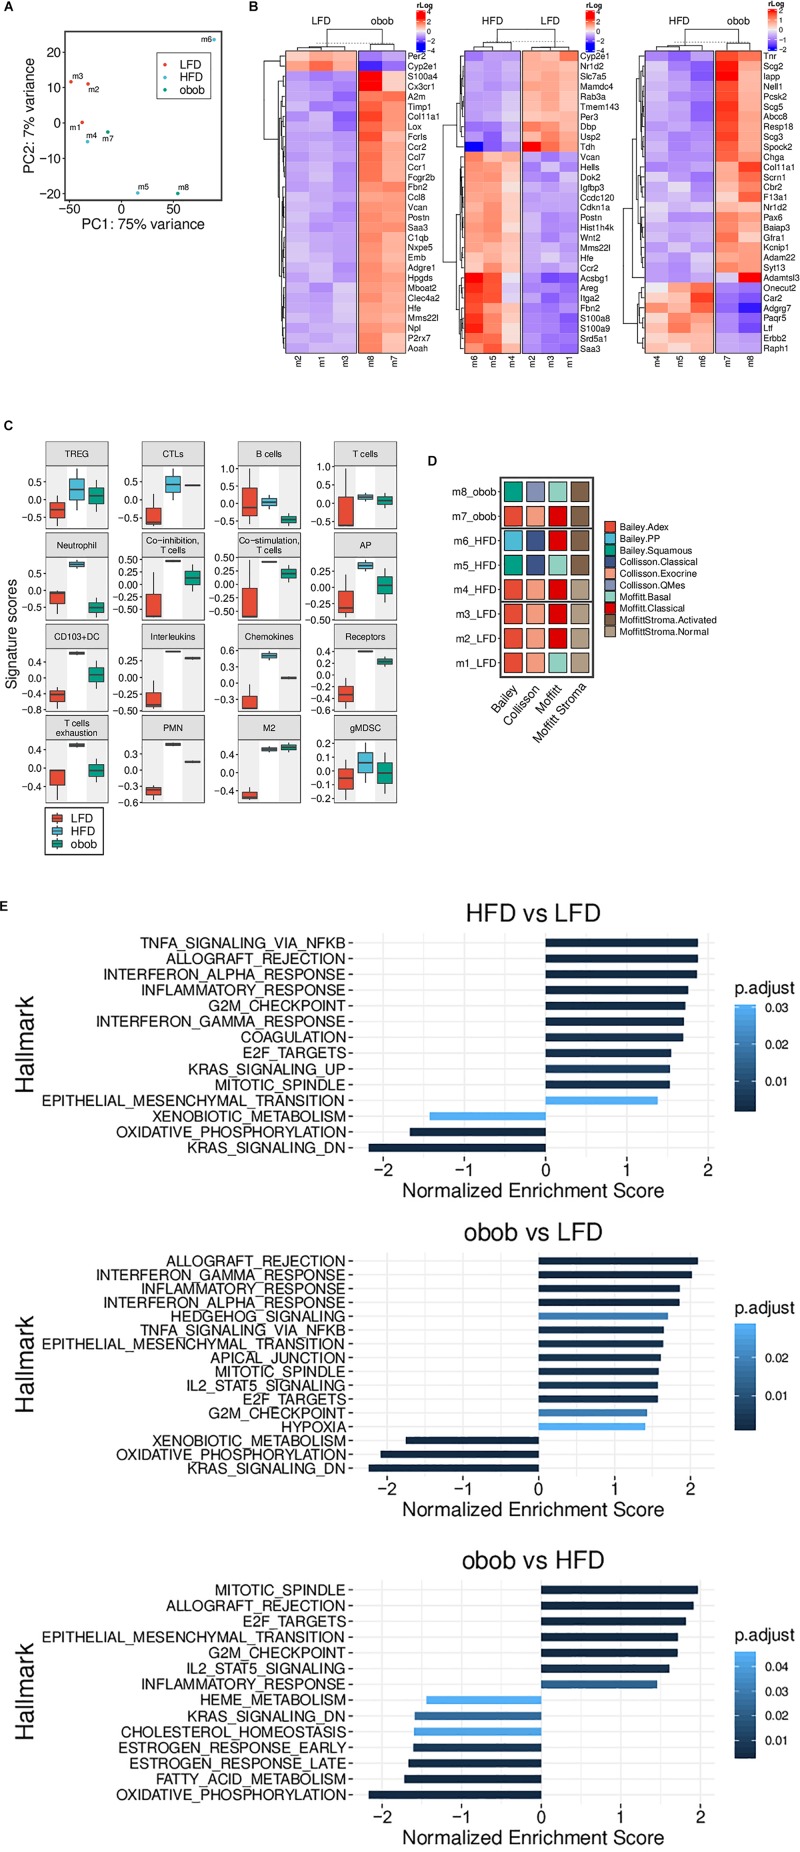
Obesity-induced carcinogenesis and progression of mT organoids models are associated with changes of gene expression profile. (A) RNA-Seq based PCA showing a homogeneous cluster of LFD mice, while HFD and ob/ob ones display a more heterogeneous profile. (B) Heatmap of the differentially expressed genes from mT of obese and lean mice. Top 30 genes with an adjusted p-value < 0.05 are reported. (C) Boxplots showing the RNA-Seq based GSVA scores of different custom gene sets (LFD, n = 3, HFD, n = 3, ob/ob n = 2). (D) The panel represents the RNA-Seq based subtyping for each individual mT mice of the three groups. A sample was assigned to a Bailey, Collisson or Moffitt (Stroma subtypes separated) subtype when its GSVA score was highest within that subtype group. LFD mice are clearly more homogenous than HFD and ob/ob. (E) Results of the pre-ranked GSEA applied to the results of the differential gene expression between the three pairs indicated. Only gene sets with an adjusted p-value < 0.05 are displayed.